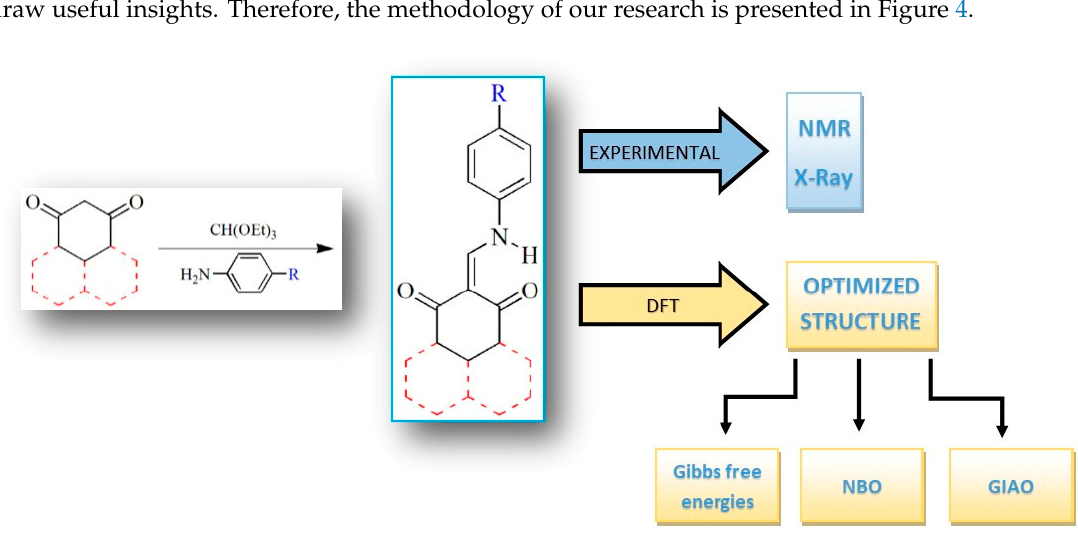
Figure 4. Materials used in research and methodology.